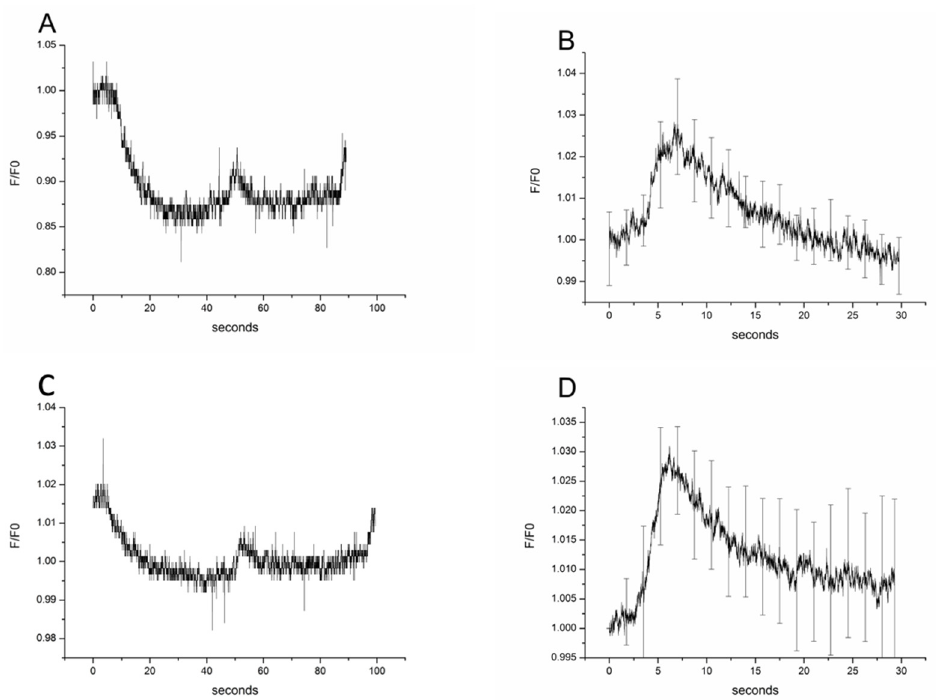
Figure 3. Effect of isotonic gradients (100 mM) of myo-inositol and urea on the cell volume of rat primary peritoneal mesothelial cells. A typical recording profile with myo-inositol incubation is given in ( A ) and the profile of the mean and SE of 18 experiments in ( B ). Typical recording profile of rat peritoneal mesothelial cells incubated with urea ( C ) and profile of mean of 18 experiments ( D ). The ( B , D ) are the second part of the curves of ( A , C ) respectively, reflecting cell volume changes. They are normalized to the starting volume and the mean values of every point are used to get the mean profiles.